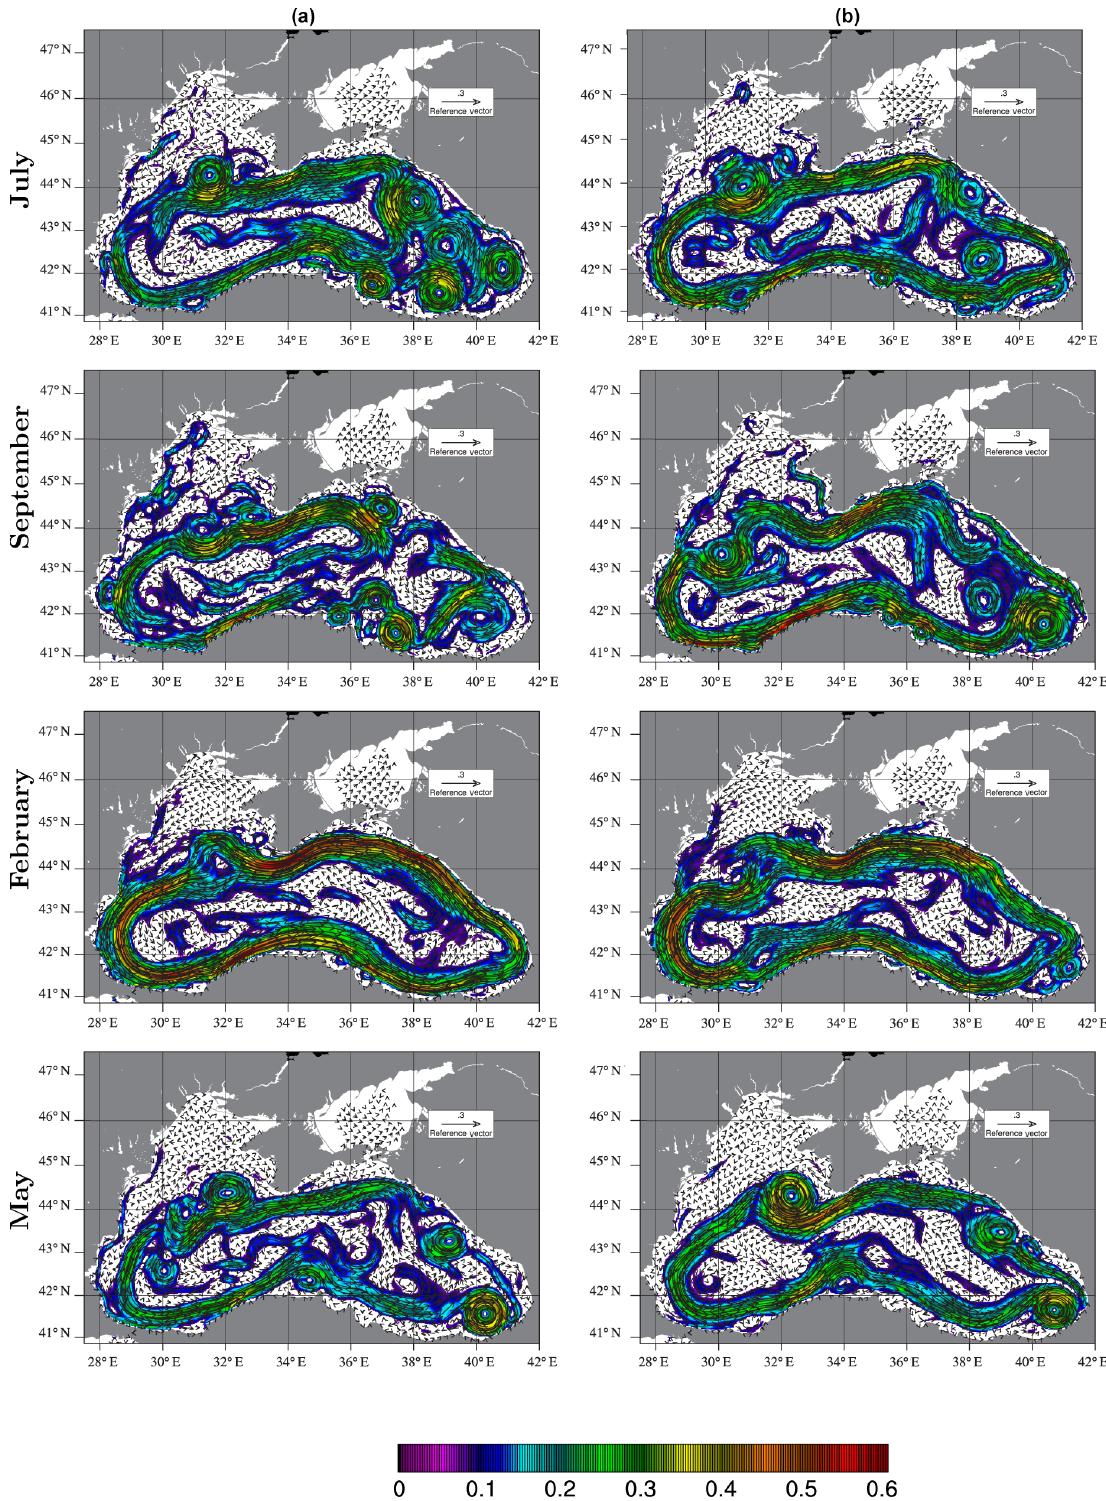
Figure 13. Monthly average current vectors and magnitude in color shading for the months of July, September 2011, February, May 2012 (a) and July, September 2014, February, May 2015 (b) (ordered down the